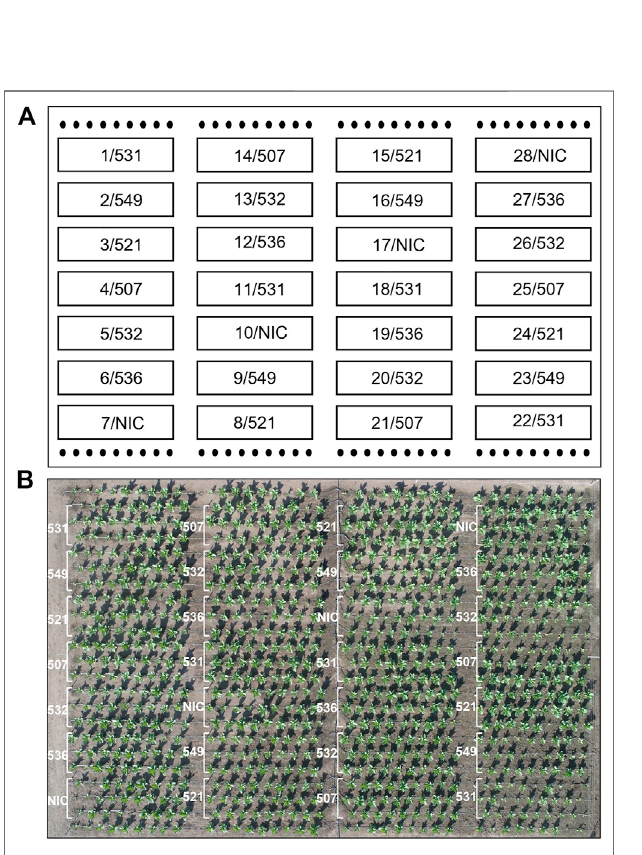
Frontiers in Bioengineering and Biotechnology |